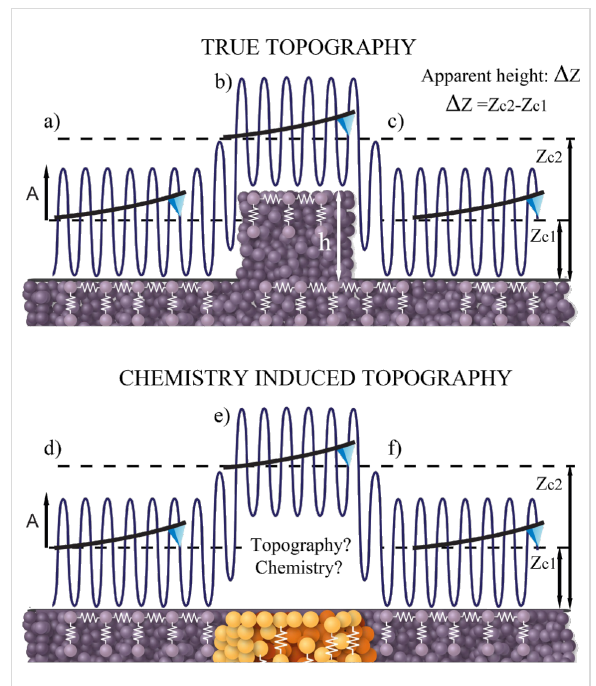
Figure 4: (a–c) Illustration of a cantilever oscillating above a surface and recovering the true height Δ z c = h when there are no composi- tional heterogeneity or chemical variations. (d–f) Topographical varia- tions Δ z c > 0 nm induced by chemical or another compositional hetero- geneity. The two cases can be decoupled by noting that it is only a compositional heterogeneity, if the phase shifts of higher harmonics, Δ , are